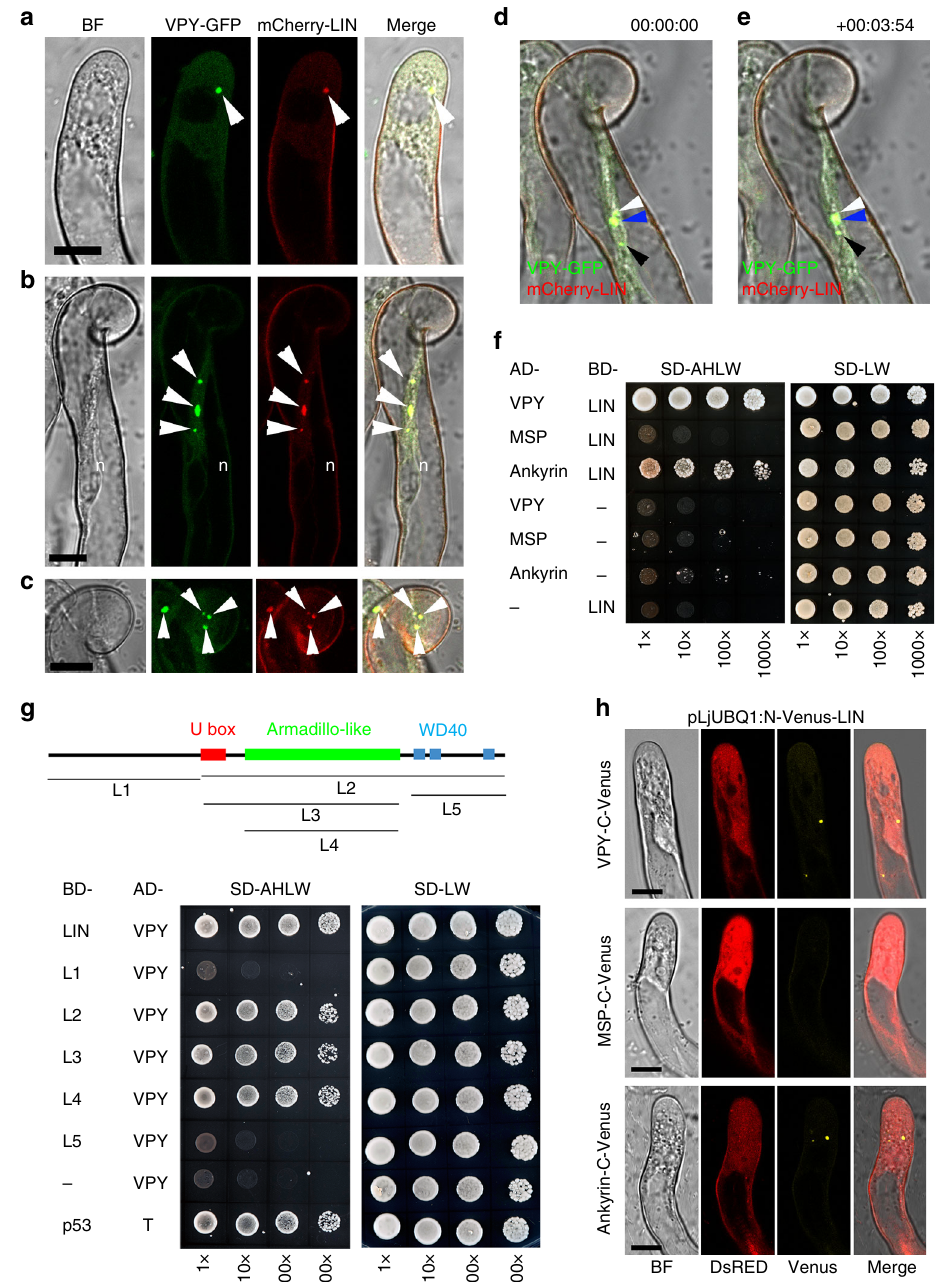
Fig. 5 Interaction of VPY and LIN. a – c Live cell confocal images of root hairs from transgenic plants containing pVPY:VPY-GFP and pLjUBQ1:mCherry-LIN showing co-localization of VPY and LIN after inoculation with rhizobia. d , e Live cell images from the root hair tip shown in b , c at two time points (0 ″ and 3 ′ 54 ″ ) showing the movement and fusion of VPY-GFP/mCherry-LIN labeled puncta. f – g Yeast two-hybrid assays: between LIN and VPY, MSP domain of VPY and ankyrin repeats of VPY, respectively ( f ) and between VPY and different domains of LIN ( g ). The combination of proteins expressed in either the AD vector (pGADT7) or the BD vector (pGBKT7) are indicated alongside the yeast colonies. Diploid yeast cells with a series of 10- fold dilutions were grown on either SD-Leu-Trp (SD-LW) or SD-Ade-His-Leu-Trp (SD-AHLW) media. h Bimolecular Fluorescence Complementation (BiFC) experiments after inoculation with rhizobia. Split Venus fl uorescent protein was used, with N-Venus fused to LIN driven by pLjUBQ1 promoter and C-Venus fused to VPY, MSP domain or ankyrin repeats containing domain of VPY driven by VPY promoter. DsRED was used as a transgenic marker. DsRED and GFP images were pseudo coloured in red and green, respectively. n, nucleus; Arrowheads, VPY-GFP/mCherry-LIN puncta. Scale bars, 10 µ the lin-1 mutant inoculated with S. meliloti . Compared with wild due to a genuine decrease in the number of labelled puncta, or type, the VPY-GFP signal was much reduced in lin-1 , both in the from the dif fi culty of detecting puncta with lower fl uorescence puncta and the cytoplasm (Fig. 7a). In addition, quanti fi cation of levels. To distinguish between these two possibilities, the fl uor- the average number of VPY-GFP puncta per root hair revealed a escence intensity of the largest punctus per root hair was deter- >2 fold decrease in lin-1 compared to WT (Fig. 7b). This could be mined for both lin and WT plants. We found that the intensity of